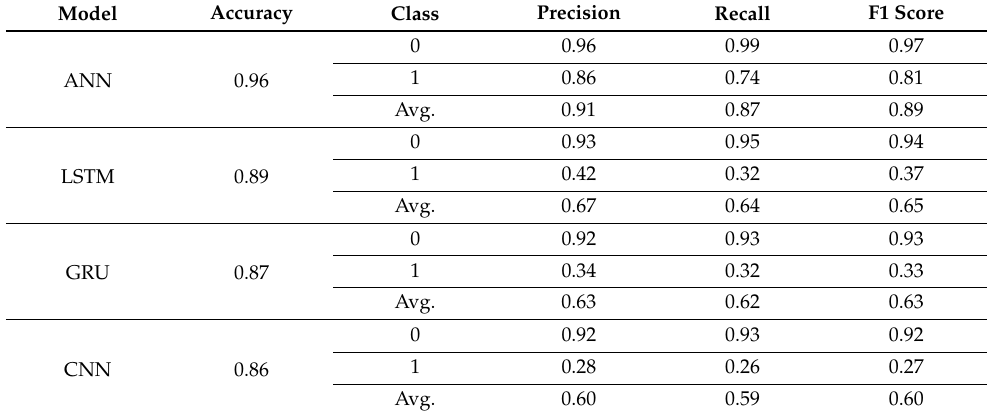
Table 8. Performance of deep learning models.